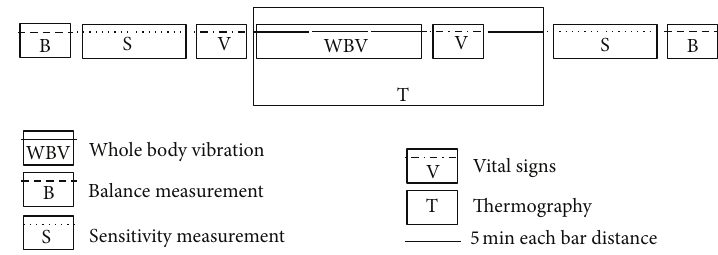
Figure 1: Protocol timeline for one single session. Each bar distance corresponds to 5 minutes in the